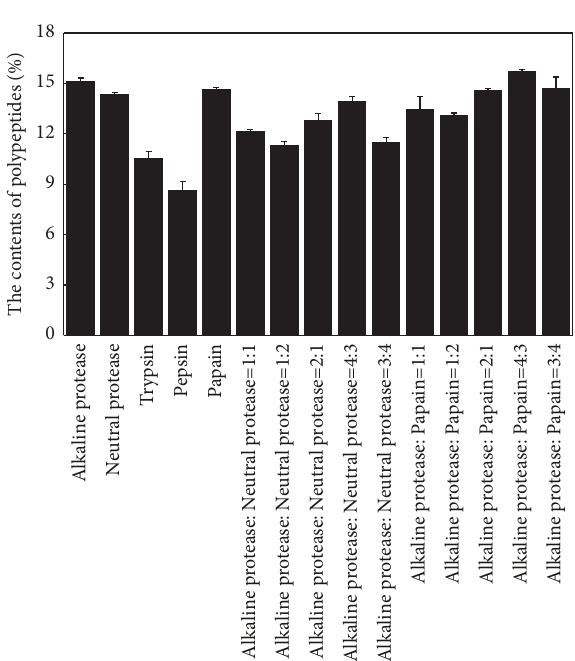
Figure 3: Peptide yield of enzymatic hydrolyzed in C. militaris